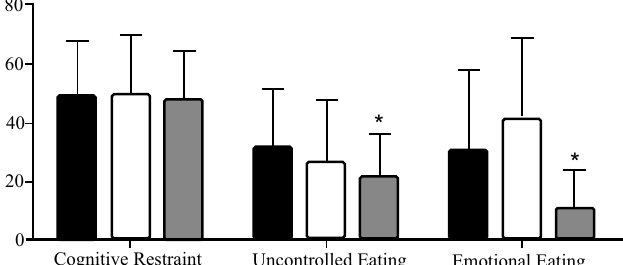
Figure 1. Eating behaviors evaluated by TFEQ-21 in physically active men and women. Variables showed in mean ± standard deviation; Black bars, all participants; White bars, female participants; Gray bars, male participants. *Significant difference between men and women (ANOVA one way, post hoc Tukey; p <